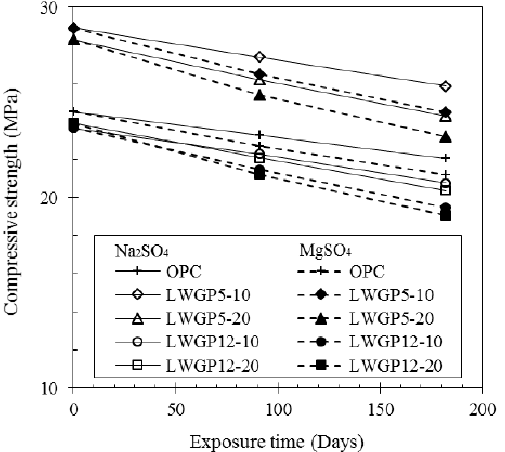
Figure 7. Variation of the compressive strength for the concrete containing LWGP powder under sulfate-bearing environments.